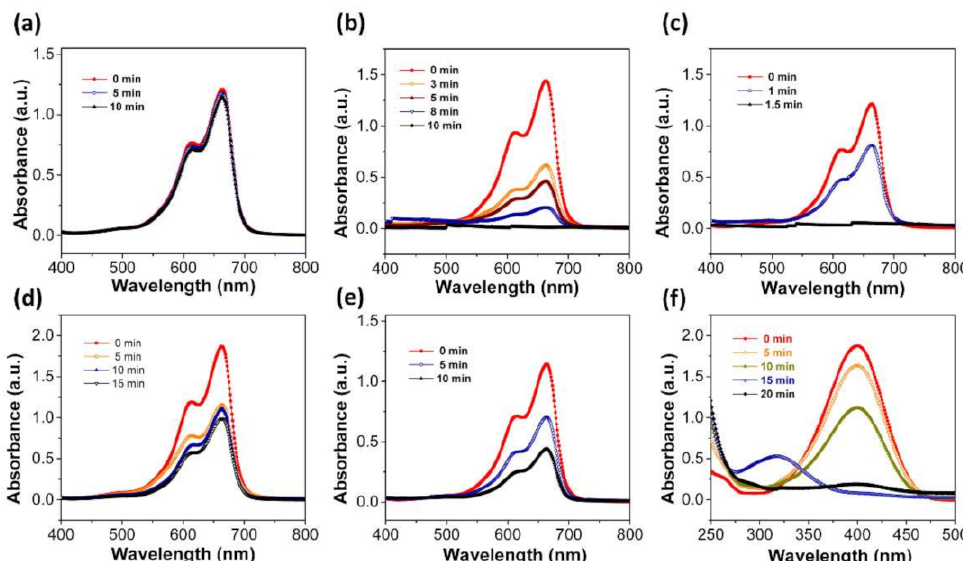
Figure 8. Characterization of catalytic performance of MLGP/PAA and MLGP/ Ag 0 /PAA hydrogels. ( a ) UV-VIS spectrum of mixture solution of MB and NaBH 4 , ( b ) catalytic performance of MLGP/PAA hydrogel to reduce MB, ( c ) catalytic performance of MLGP/ Ag 0 /PAA hydrogel to reduce MB, ( d ) pure PAA hydrogel adsorption capacity of MB, ( e ) MLGP/PAA hydrogel adsorption capacity of MB, and ( f ) catalytic performance of MLGP/PAA hydrogel to reduce